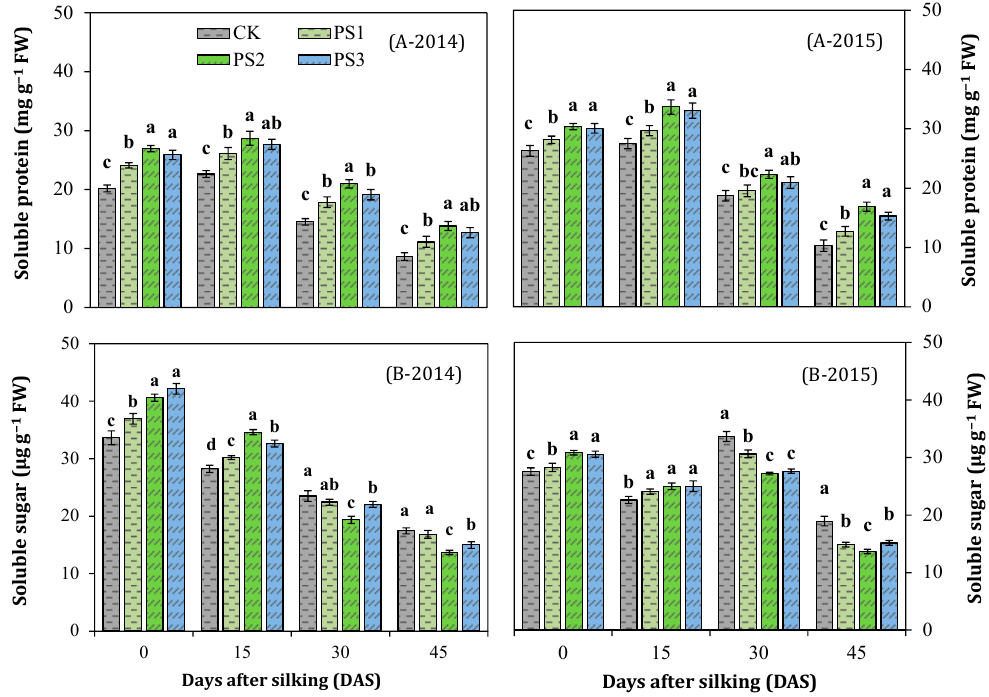
Figure 9. Effects of paclobutrazol treatments on (A) soluble protein and (B) soluble sugar contents in maize leaves during 2014 and 2015. Data are presented as mean ± SD of three measurements. Different small letters on the bars indicate significant differences at P < 0.05 (LSD test). The abbreviations of treatment names are the same as those described in Figure 2.